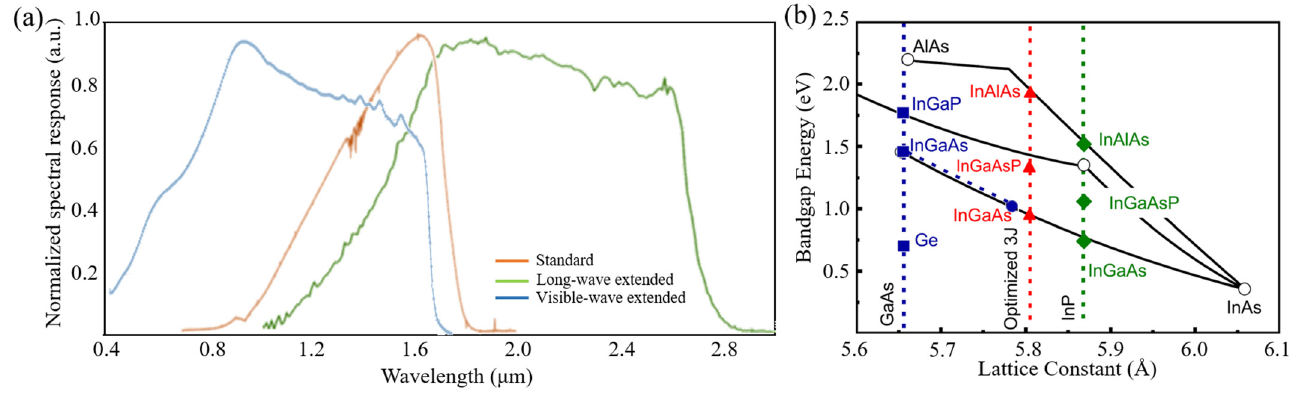
Long-wave Extended